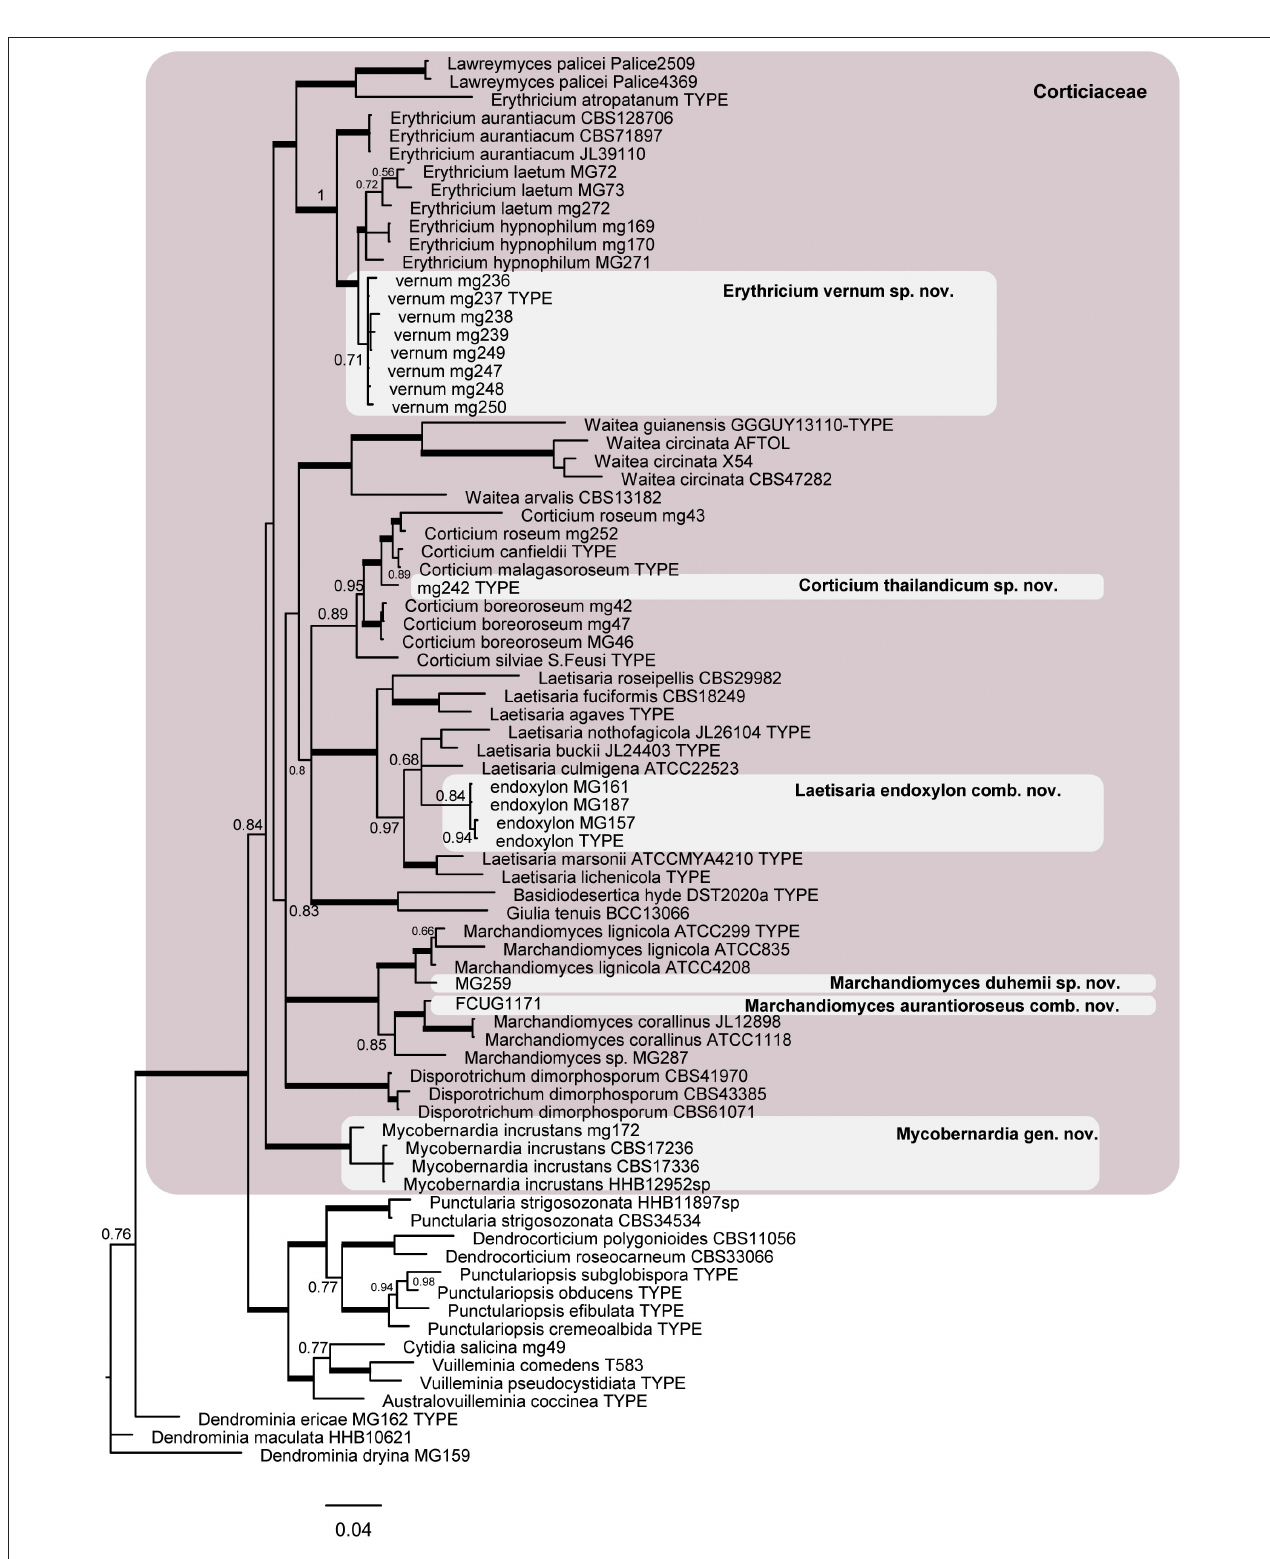
FIGURE 3 | Phylogram of the nLSU-ITS dataset representing the Corticiaceae family (pink box) and taxonomic novelties in the Corticiaceae. Branches in bold have the posterior probability = 1.00. The scale bar represents the expected changes per site.